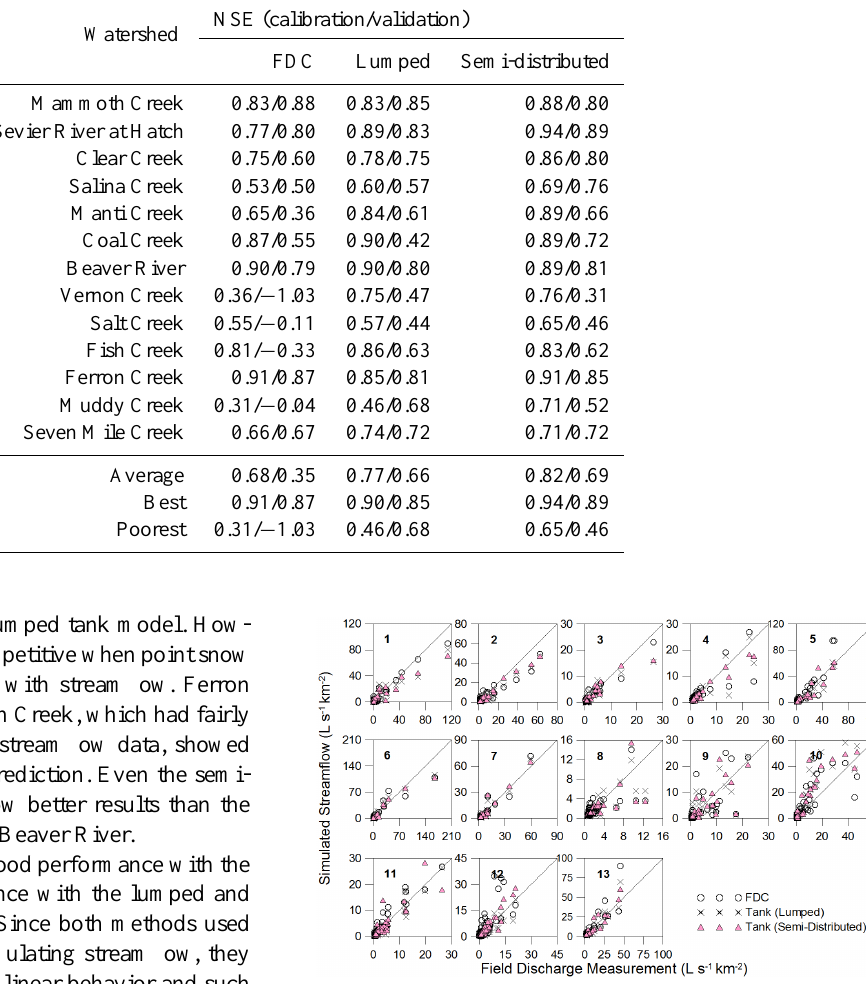
Table 2. Performance comparison between the FDC method and the tank models.